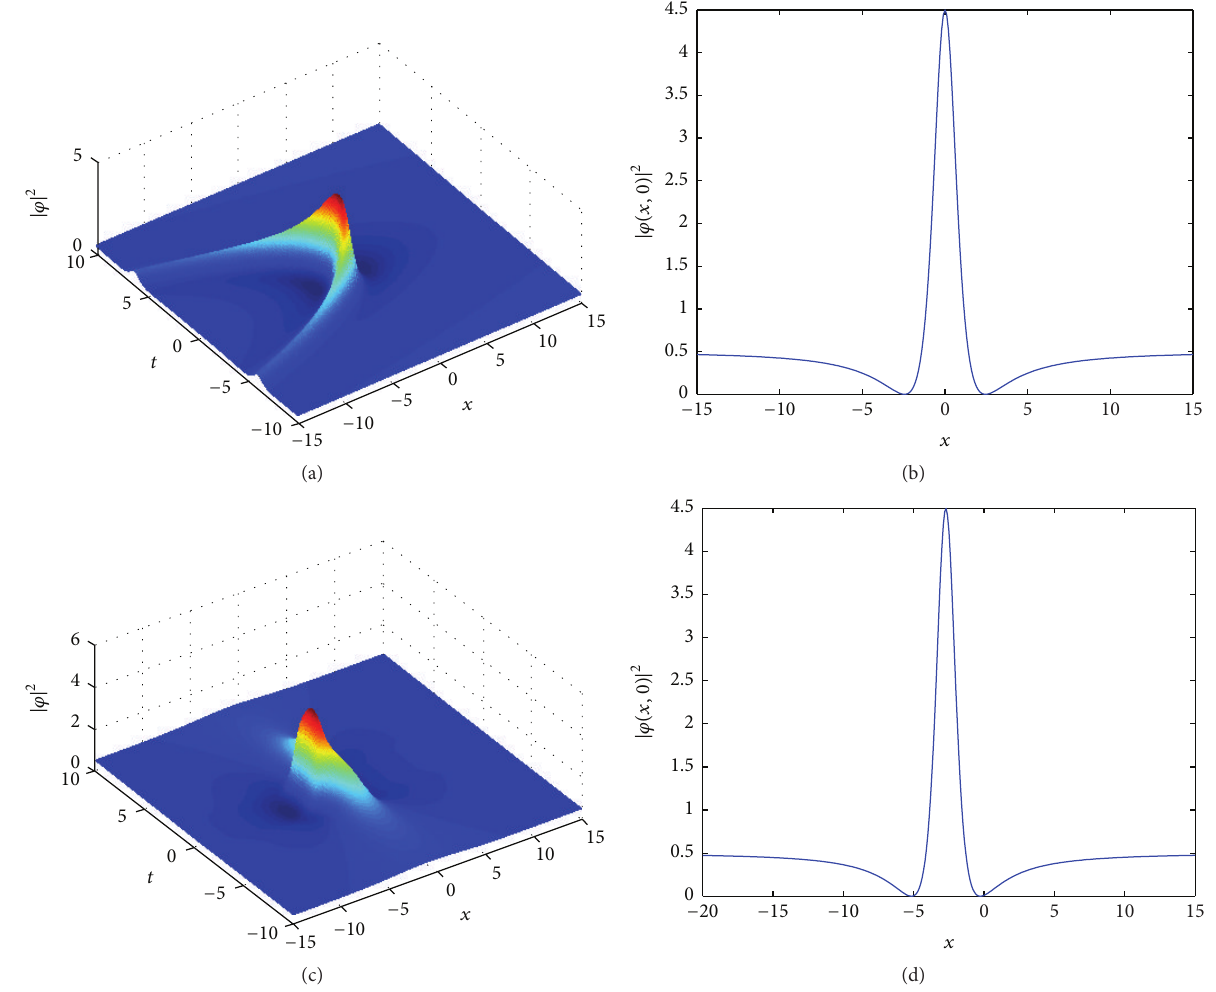
Figure 4: The first-order rogue waves propagation for the intensity |𝜑| 2 with the gravity field 𝑏 = 0.5 and (a)-(b) 𝛽(𝑡) = 0.2𝑡 2 , (c)-(d) 𝛽(𝑡) = 0.5 exp ( sech (0.2𝑡 3 ))